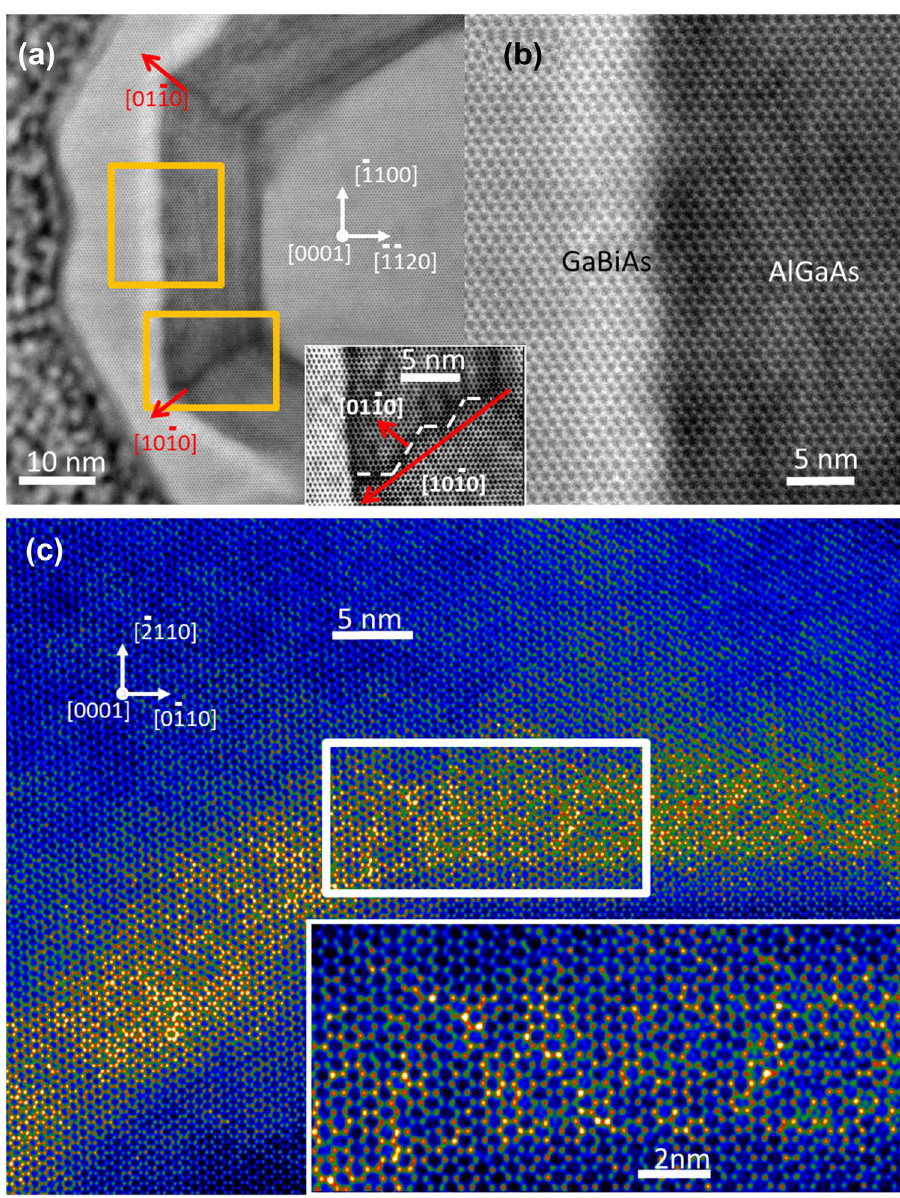
Figure 6. The analysis of a thin cross-section of the WZ GaAs-(Ga,Al)As-Ga(As,Bi) NW segment. ( a ) HR-STEM image acquired with the camera length of 73 mm; ( b ) zoomed part of the interface between (Ga,Al) As and Ga(As,Bi) shells; the inset to ( a ) and ( b )—zoomed filtered image showing details of Al segregation at the NW corner; ( c ) HR-STEM (in false colors) of about 20 nm thick cross-section of Bi-rich shell; yellow color represents Bi-rich atomic columns averaged over 20-nm thick specimen, the inset shows zoomed area enclosed by the white